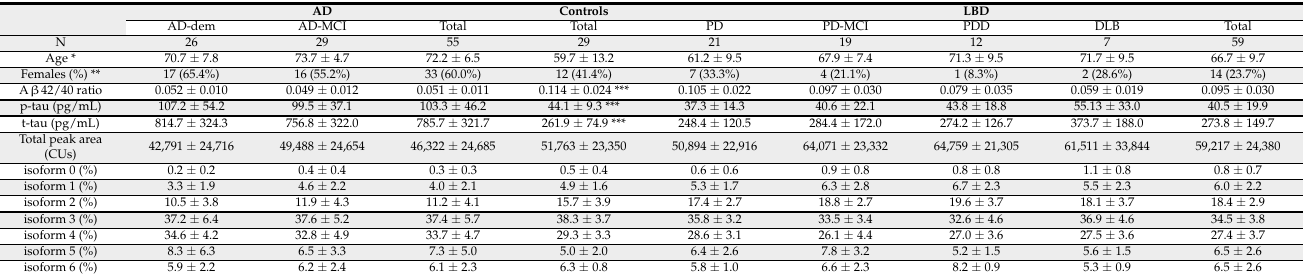
Table 1. Demographic and biochemical data of the diagnostic